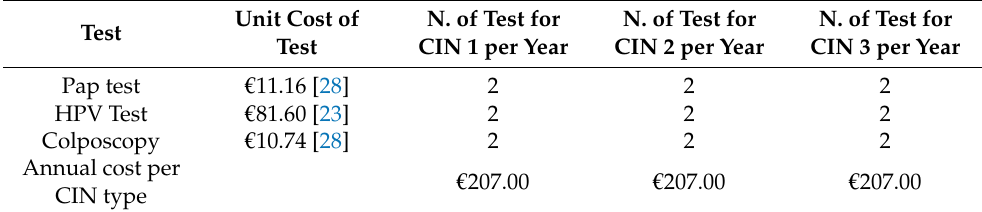
Table 5. Annual cost of follow-up by grade of HPV-related